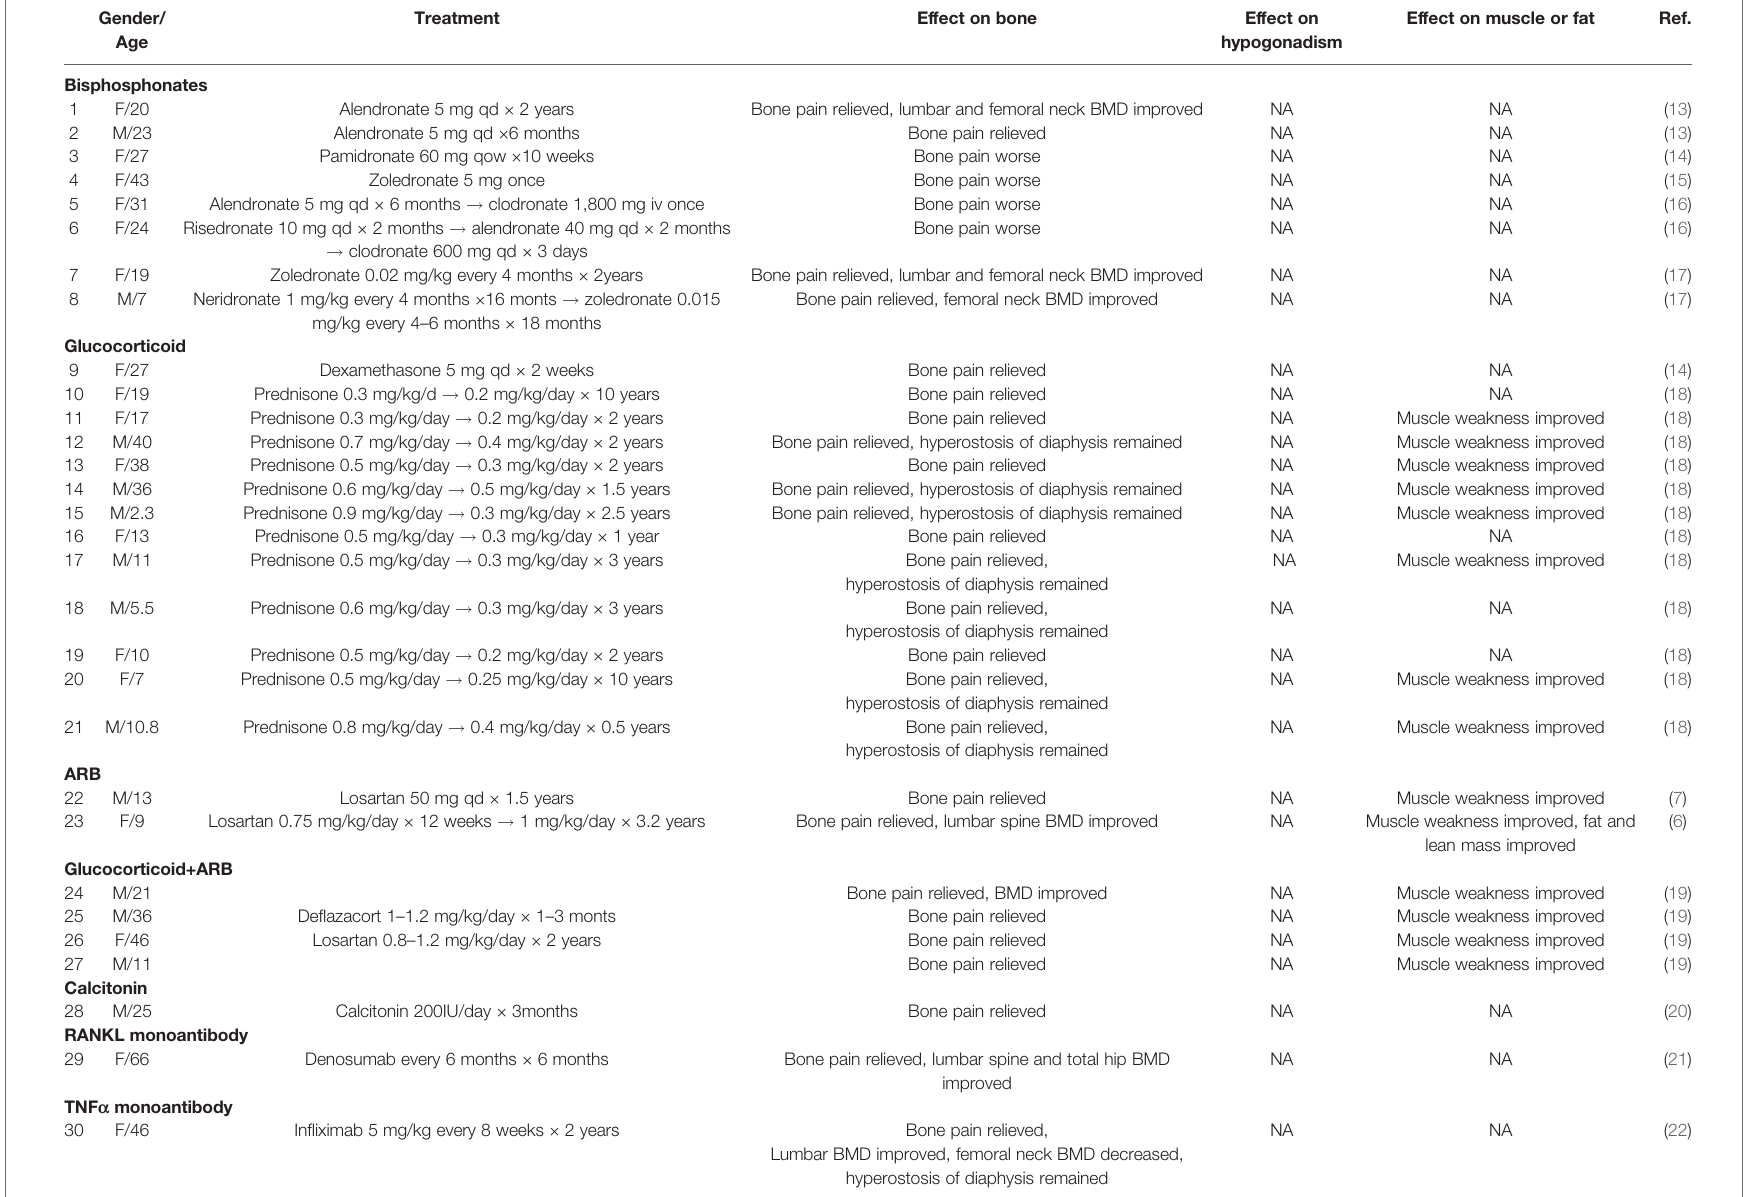
TABLE 2 | Summary of case reports on the treatment effect on bone and hypogonadism in patients with CED. Gender/ Treatment Effect on bone Age